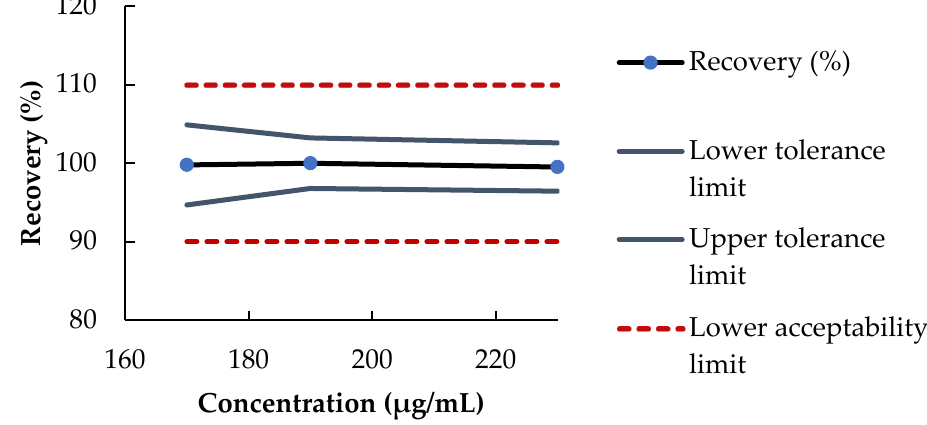
Figure 2. The 95% accuracy profile of the method according to the Met concentration.